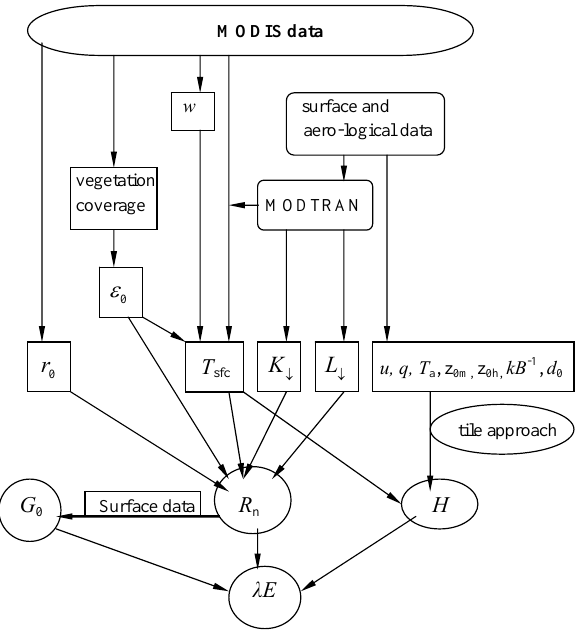
Fig. 2. The diagram of parameterization procedure to determine surface reflectance, surface temperature, net radiation flux, soil heat flux, sensible heat flux and latent heat flux by combining MODIS data with field observations.